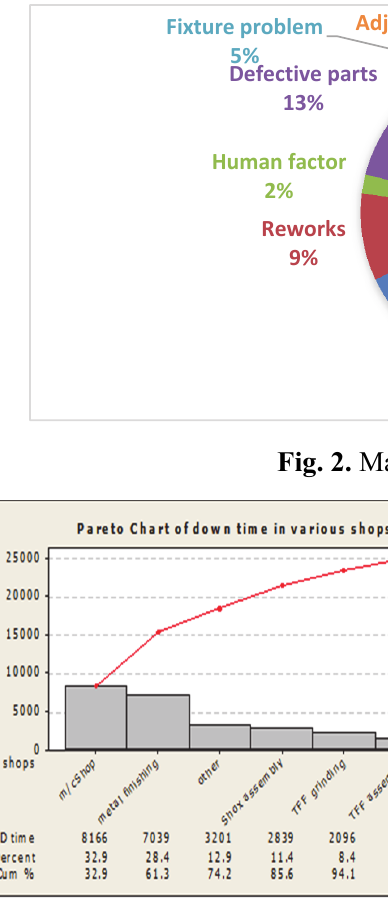
SIPOC Diagram of M/C Shop Fig. 4. Fig. 3. Pareto chart for shop wise down